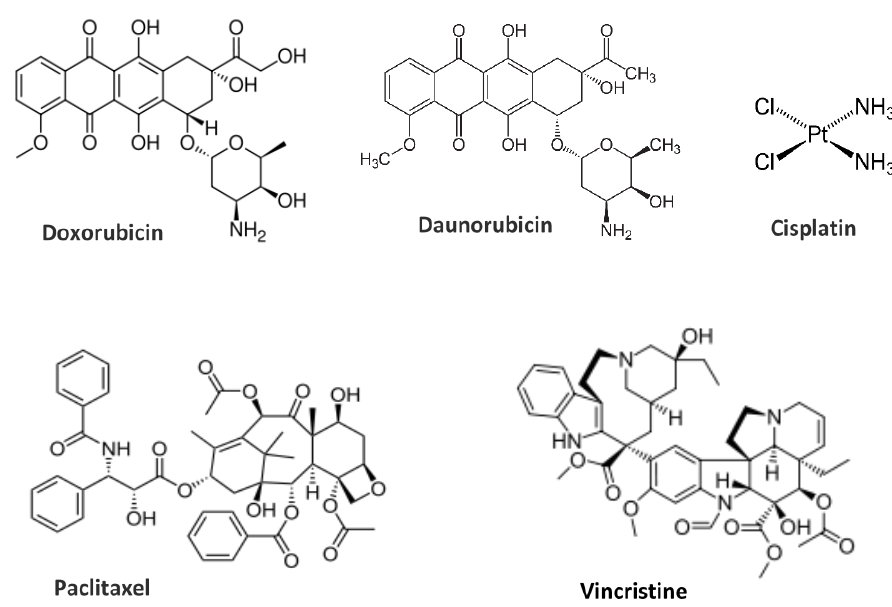
Figure 10. Chemical structures of drug molecules employed in liposomal formulations for clinical trials in the treatment of different typology of cancer.